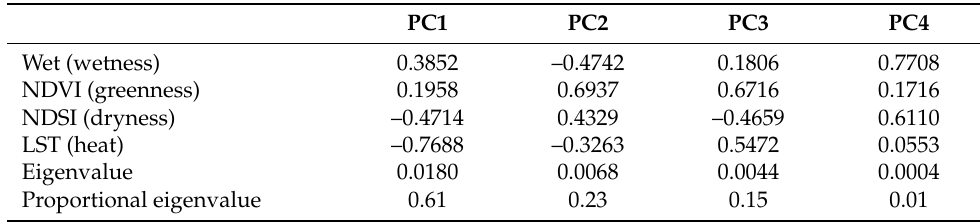
Table 1. Eigenvector statistics for four